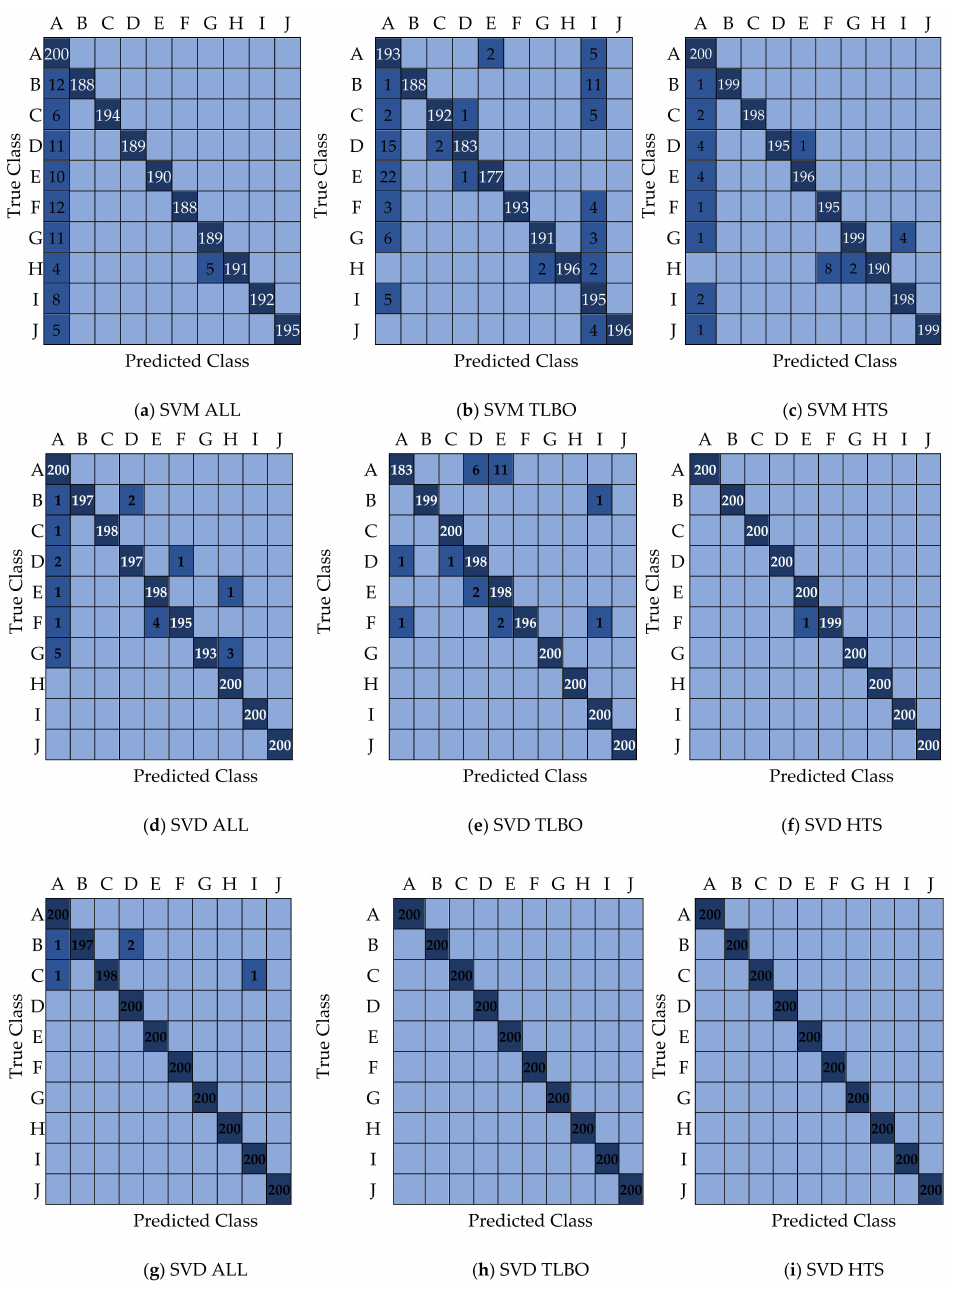
Figure 13. ( a – i ) Confusion matrix from Ten-fold CV with SVM, SVD, and ELM ML